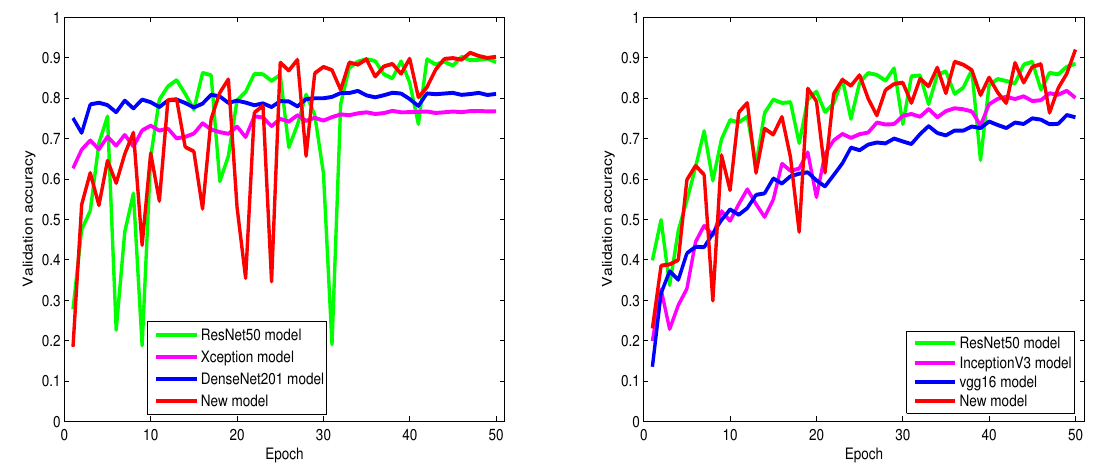
Figure 4. From left to right: the validation accuracy of the trained models on the Intel Image Classification and CIFAR-10 datasets.